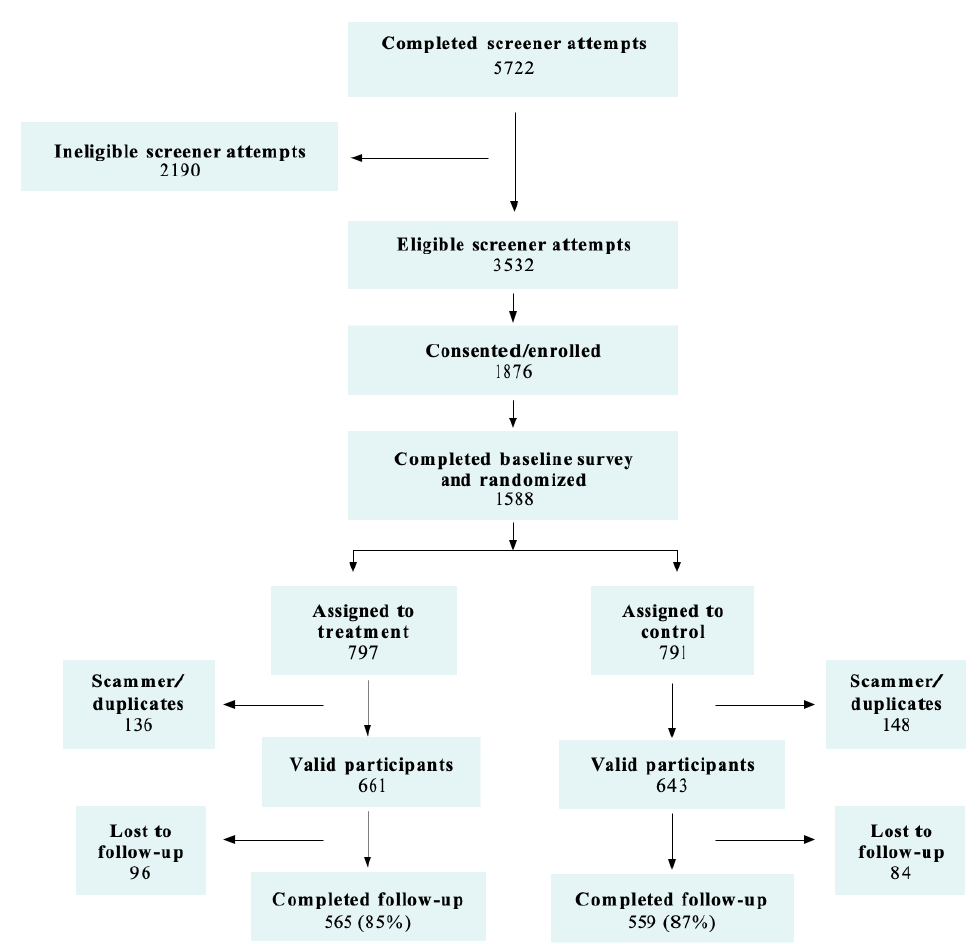
Figure 1. Pulse participant flow diagram.